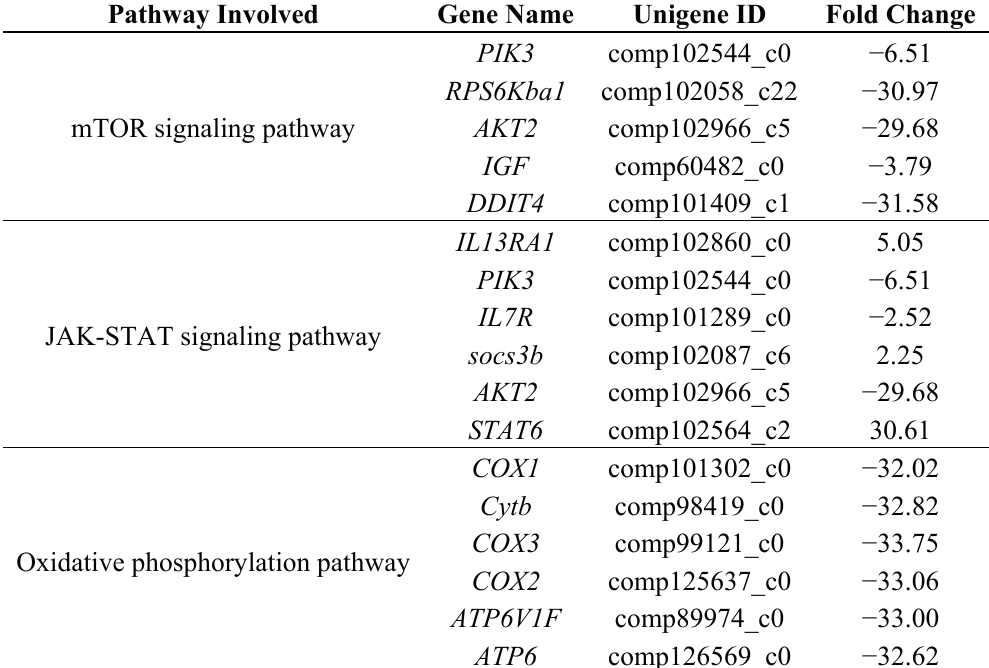
Table 4. Detailed information regarding the DEGs involved in each of the three